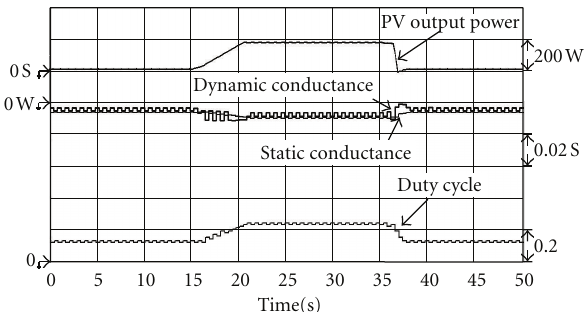
Figure 14: Simulated output power, dynamic conductance, static conductance, and duty cycle waveforms of a PV module array using the proposed extension method under irradiation that increased from 450 W/m 2 to 750W/m 2 and then dropped back to 450 W/m 2 .